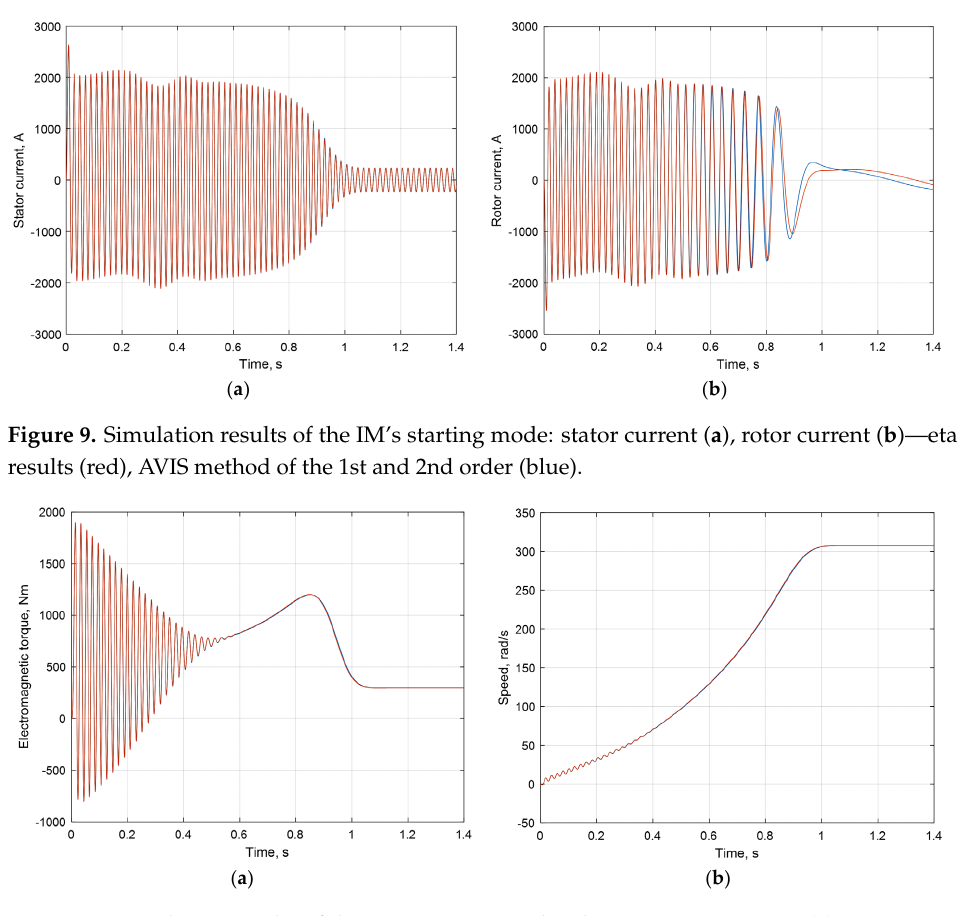
Figure 10. Simulation results of the IM’s starting mode: electromagnetic torque ( a ), rotation speed ( b )—etalon results (red), AVIS method of the 1st and 2nd order (blue).